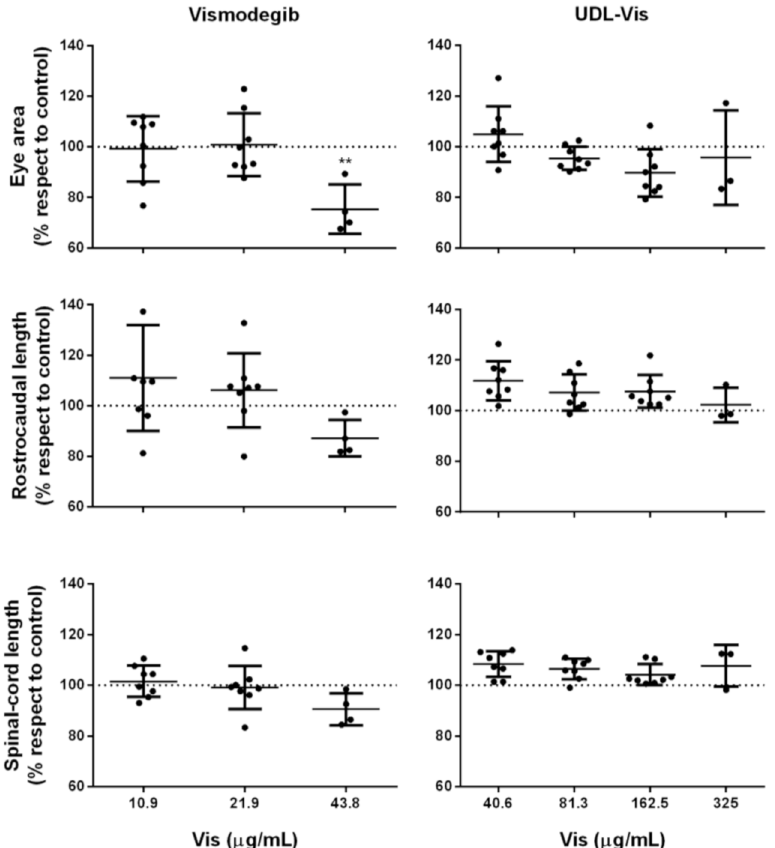
Figure 14. Morphological parameters were analyzed in larvae at 72 h post-incubation: eye area, rostrocaudal length, and spinal cord length. The measurements were carried out with the ImageJ software and were relativized to the corresponding control (dotted line corresponding to 100%). Results are shown as mean ± SD ( n = 8), ** p <